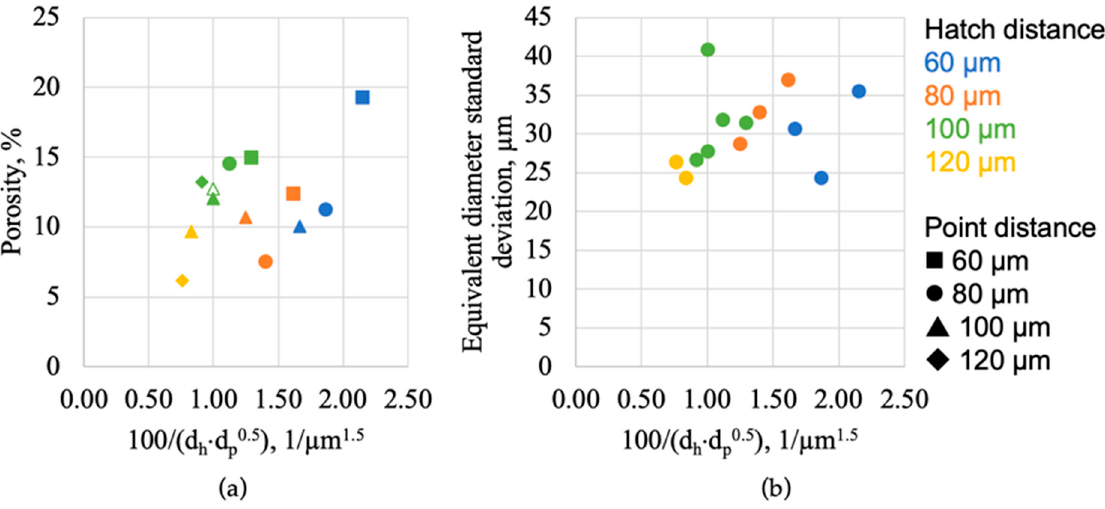
Figure 13. Porosity for each sample ( a ) and standard deviation of equivalent diameter ( b ) as function of (d h × d p0.5 ) − 1 , representing the alternative description of VED according to [29].